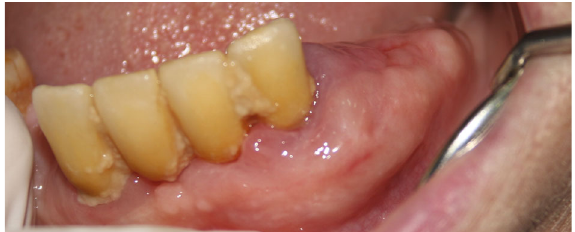
Figure 11: 1 month recall after surgical intervention of the mandibular arch. Recurrence was presented, and full-mouth exodontia was done for the lower arch.